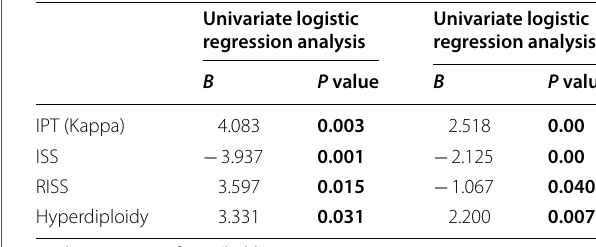
Table 4 Multivariate and univariate logistic regression analysis for predictors of treatment